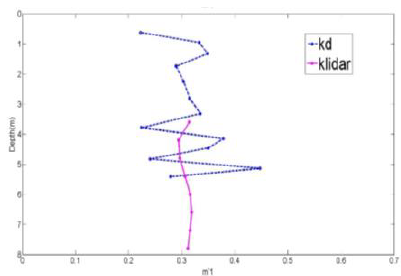
Fig 3. K lidar compared with K d measured by field instrument TriOS